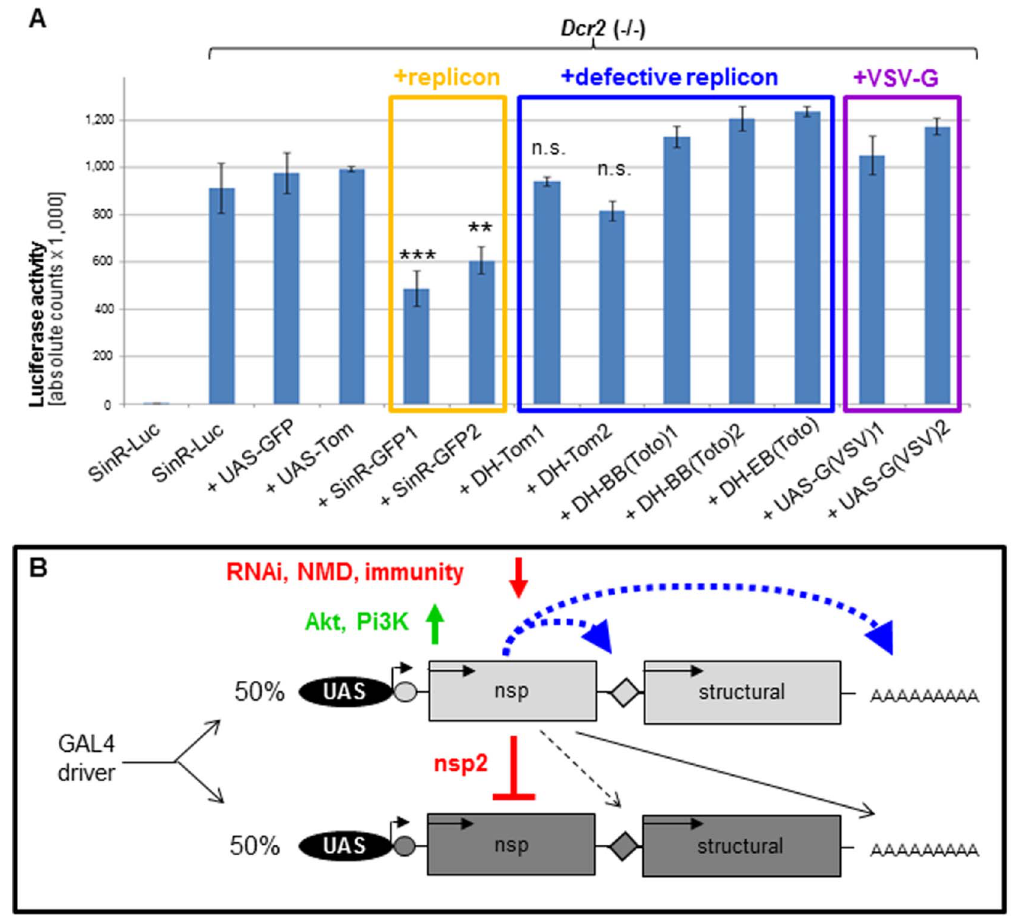
Figure 6. ORF2 does not induce exclusion and Model. A. Quantitative test whether defective helper transgenes excluded replicon expression, using SinR-Luc. In homozygous Dcr2 mutants, expression levels of SinR-Luc were unaffected by co-expression of either DH-TOM, DH-BB or DH-EB defective replicons, all harboring deletions of ORF1. Co-expression of foreign glycoproteins (UAS-G[VSV]) also had no significant effect on Luciferase expression. B. Model summarizing factors regulating in vivo replicon expression. While replicon expression is inhibited by cellular pathways (RNAi, NMD, innate immunity), a strong preference of the viral RdRP for the internal promoter on the ‘subgenomic RNA’ originating from the same transcript exists. As a result, trans-activation is weak, even from transgenes with a deleted RdRP.